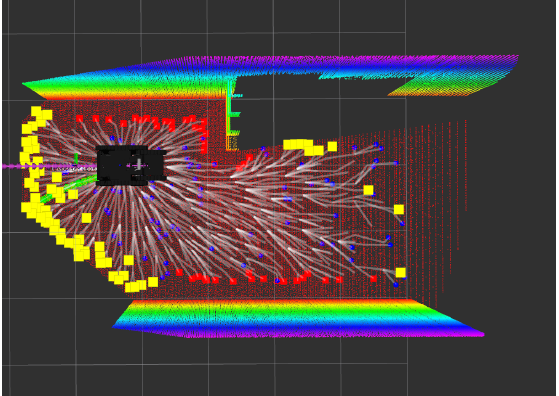
Figure 5. Example of wall-leaf rejection and frontier rejection. The tree leaves in red colour have been discarded as possible frontiers by the wall-leaf detection module. The leaves in yellow color have been accepted as frontiers by the no-frontier rejection module. 2. Visited region